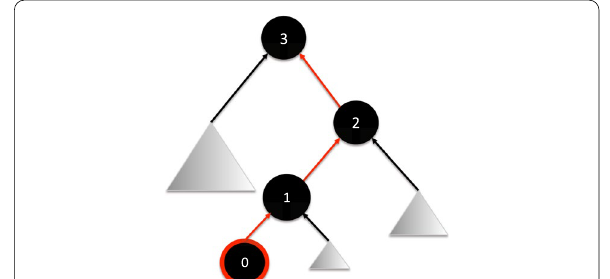
Fig. 6 A path across a sparse